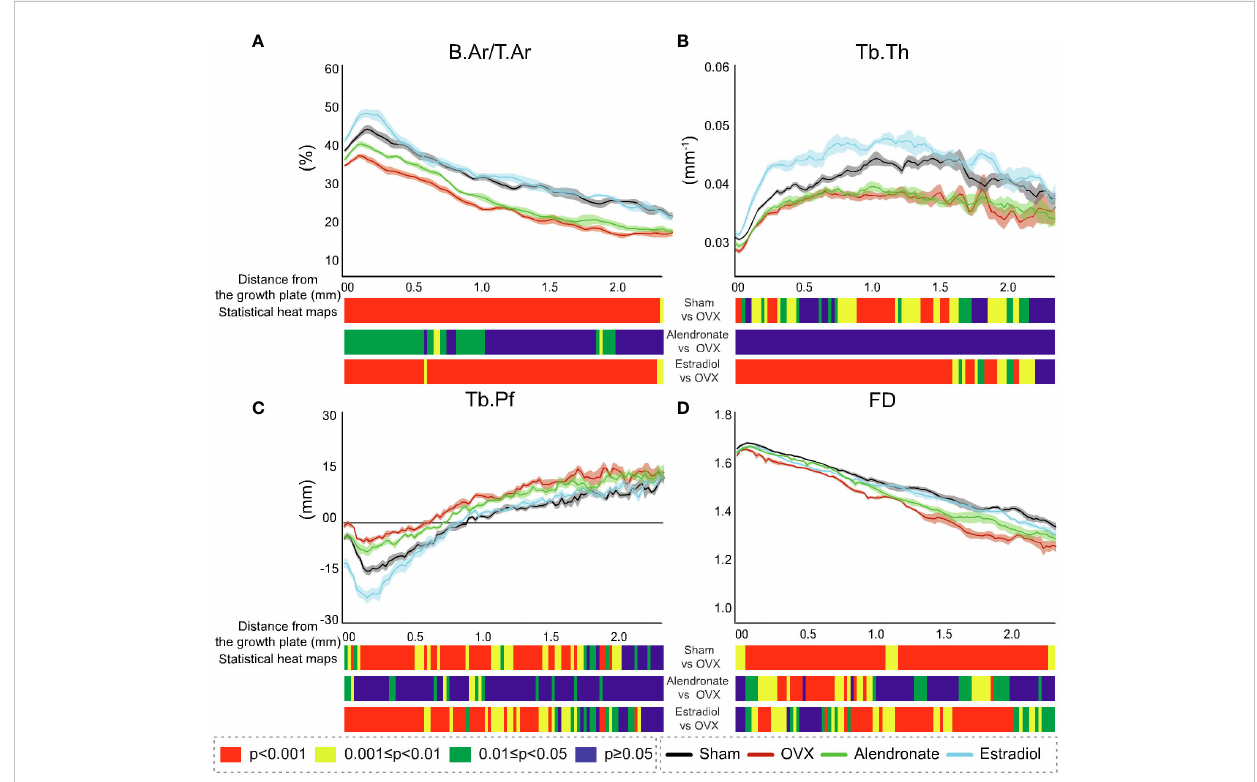
FIGURE 4 Pro fi les of the cross-sectional morphometric parameters in 2D with distance downstream of the growth plate from study (A). Corresponding pro fi les are shown for each of the four groups: sham (black line), ovariectomy (red line), alendronate (green line), and estradiol (light blue line) in B.Ar/T.Ar (A) , Tb.Th (B) , Tb.Pf (C) , and FD (D) . For all pro fi les, the SEM ranges are given. Accompanying each graph is a composite colour bar indicating, for the three inter-group paired comparisons, the slice-by-slice p -value of the signi fi cance of difference (by chi-square), again in axial pro fi le with distance downstream of the growth